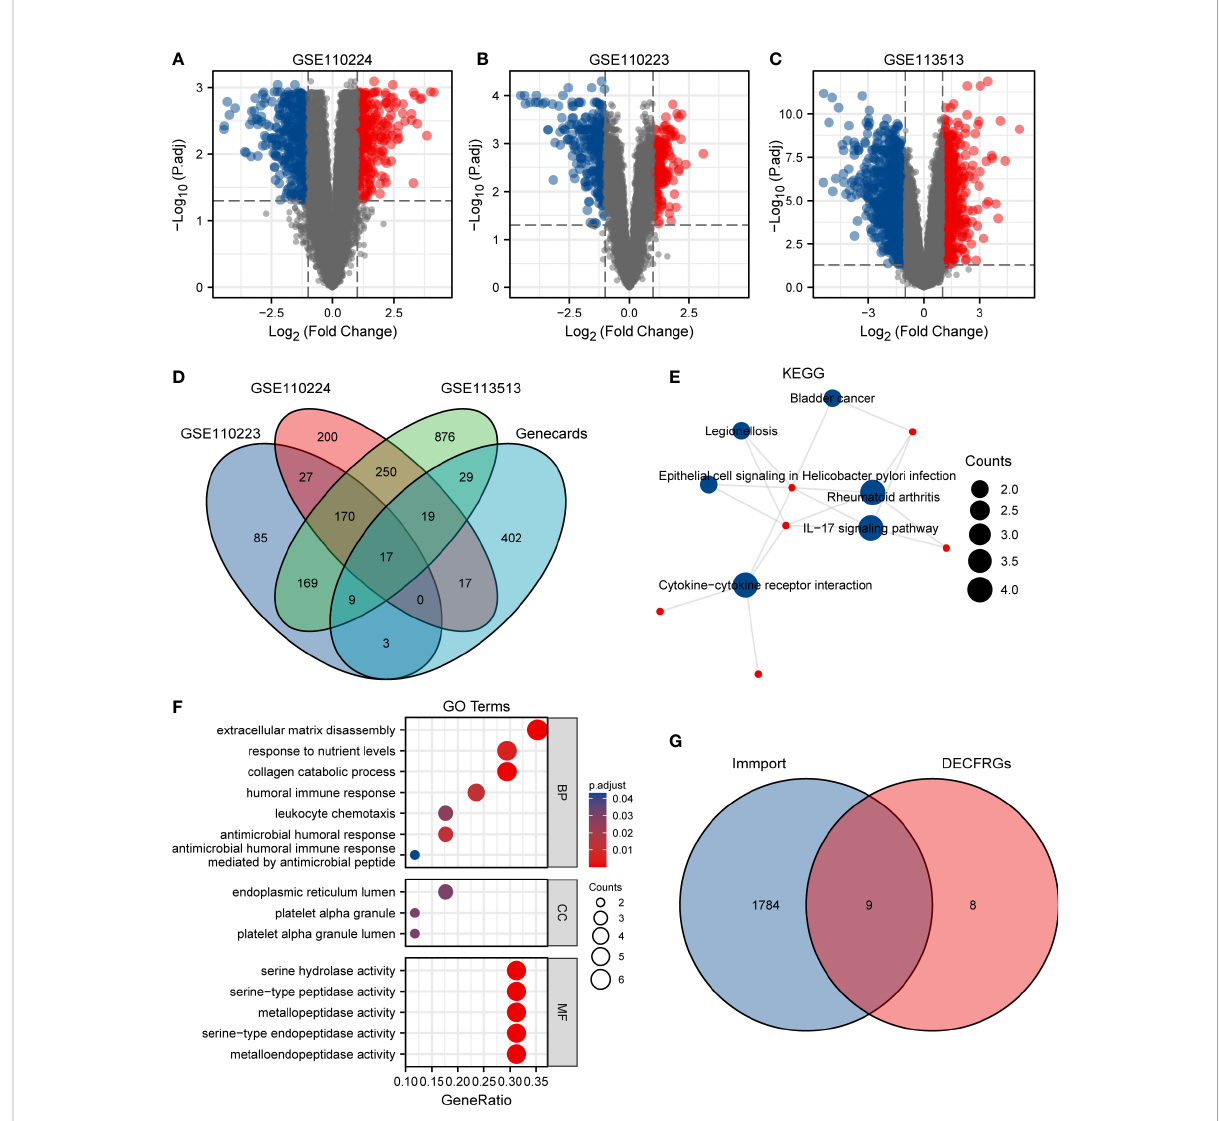
FIGURE 1 Identi fi cation of DEGs in CRC. (A) Volcano plot of DEGs between CRC and normal tissues in GSE110224. (B) Volcano plot of DEGs between CRC and normal tissues in GSE110223. (C) Volcano plot of DEGs between CRC and normal tissues in GSE113513. (D) Venn diagram visualizing the intersections of DEGs with CFRGs. (E) KEGG enrichment analysis of 17 DECFRGs. (F) GO enrichment analysis of 17 DECFRGs. (G) Venn diagram visualizing the intersections of DECFRGs with